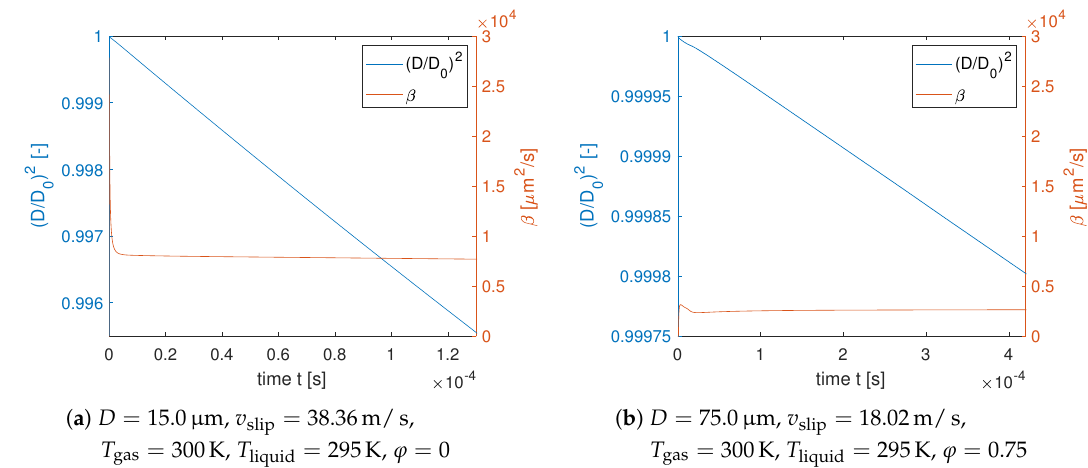
Figure 9. ( D / D 0 ) 2 and β over time for two selected simulation settings.